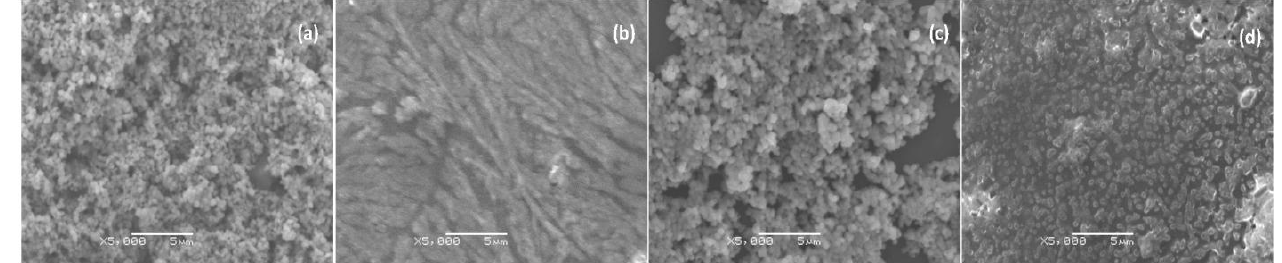
Figure 1. Scanning electron micrographs of ( a ) Fe ( c ) DNA/chitosan/Fe (HRP)-modified glassy carbon